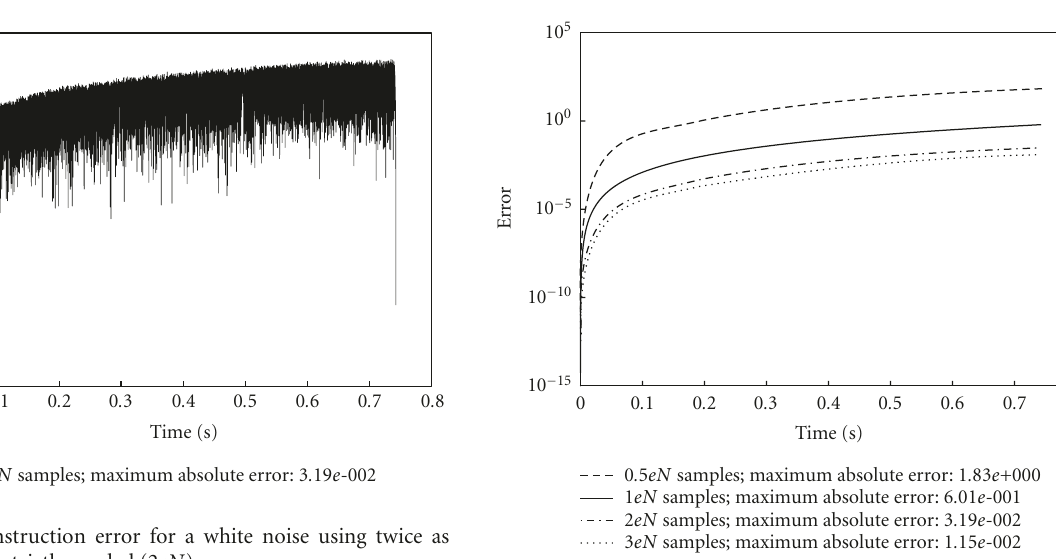
Figure 4: Error trend (in time) for a white noise. When taking twice as many samples as required (2 eN ), the maximum error of these sig- nals goes towards 10 − 2 . Each curve is derived from piecewise-linear regression of the actual error curve, as the one shown in Figure